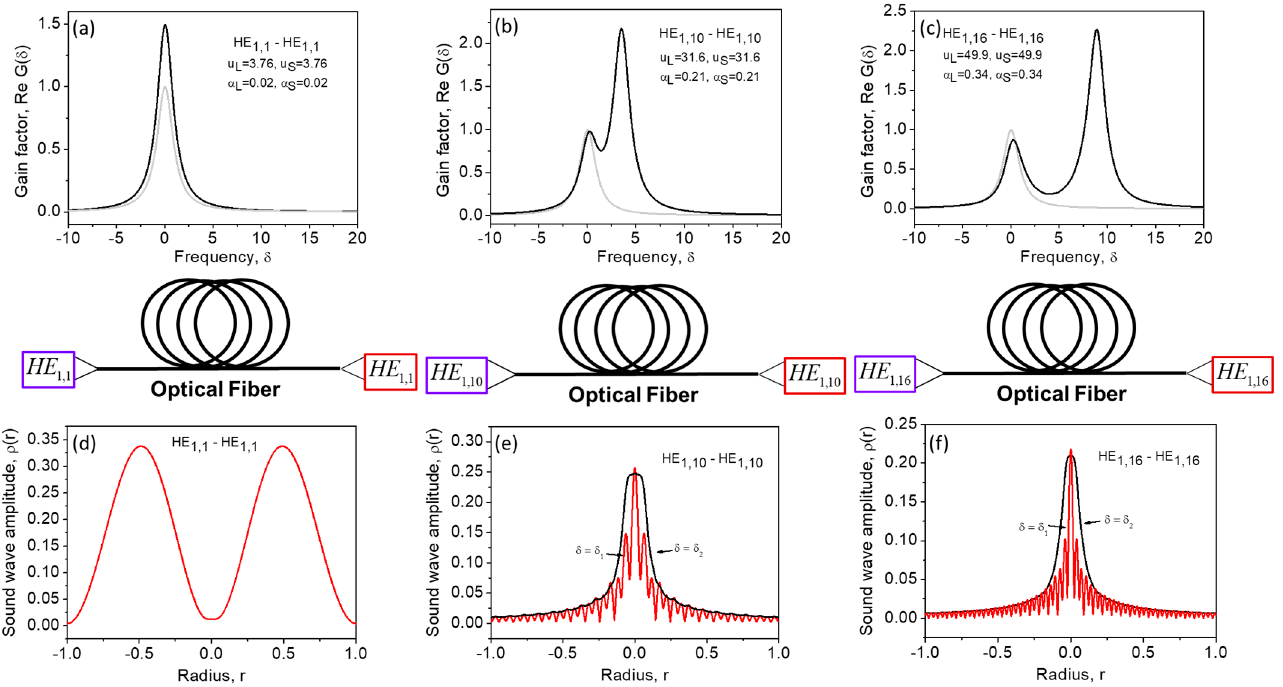
Figure 7. The SBS gain spectra G ( δ ) ( a – c ) and radial distribution of the sound amplitude ρ ( δ , r ) ( d – f ) at the frequencies δ corresponding to the left (red curve) and right (black curve) peak of the SBS gain spectra for interaction of modes of different orders ( a – f ) in an optical fiber. Calculations are performed using Equations (16), (23), (26) and (27).